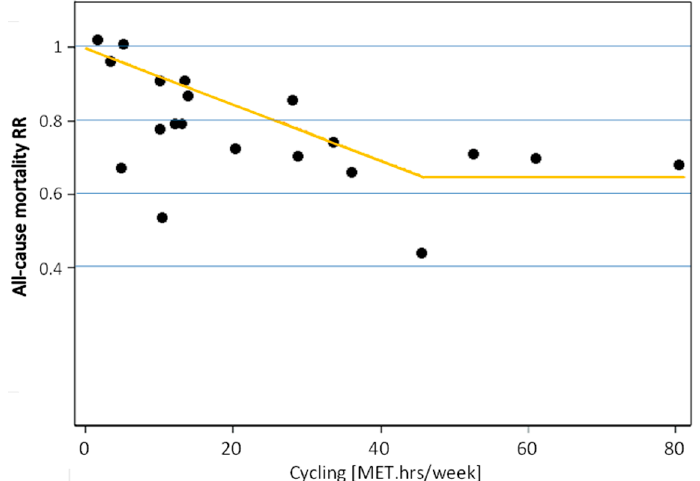
Figure 3. Response function (continuous line) for relative risk (RR) implemented in the Health Economic Assessment Tool (HEAT) for cycling on the basis of various studies (black dots) (adapted from [38]). MET, metabolic equivalent of task.